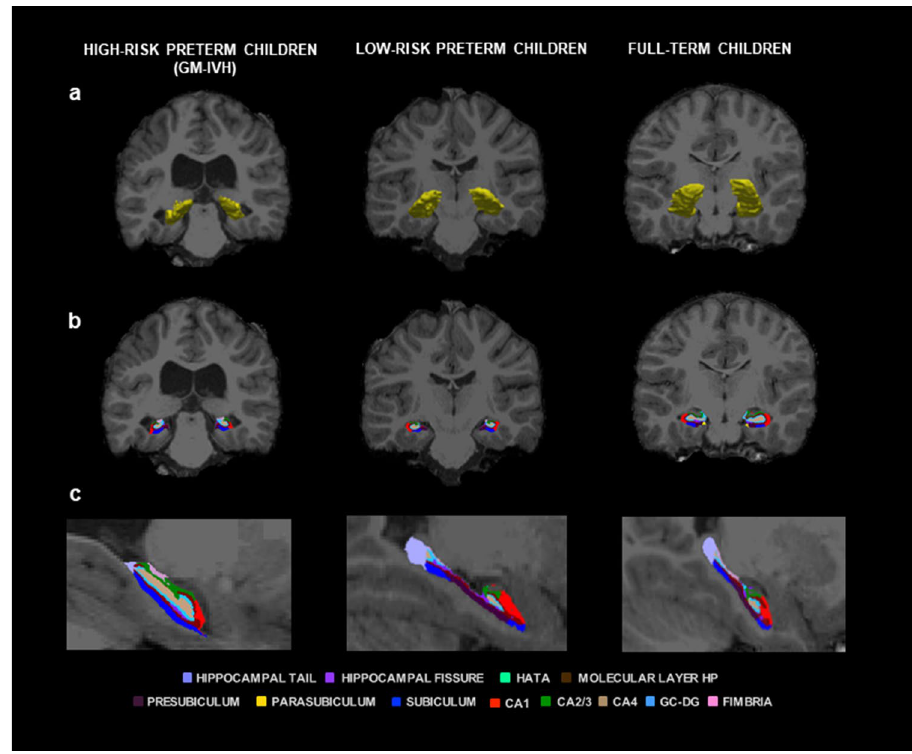
Figure 2. Right and left hippocampus and hippocampal subfield volumes. Coronal ( a , b ) and sagittal ( c ) views showing volumetric segmentation among groups in right and left hippocampus and hippocampal subfields. In accordance with radiological convention, the left side is shown on the right of the image for each view. CA: Cornu Ammonis, GC–DG: granule cell layer of dentate gyrus, HATA: hippocampal-amygdalar transition area; HP: hippocampus; and GM-IVH: germinal matrix-intraventricular hemorrhage. Coronal coordinate ( a , b ): x: -205.43, y: -11.00, z: -127.00; and sagittal coordinate ( c ): x: 2.50, y: 140.00, z: